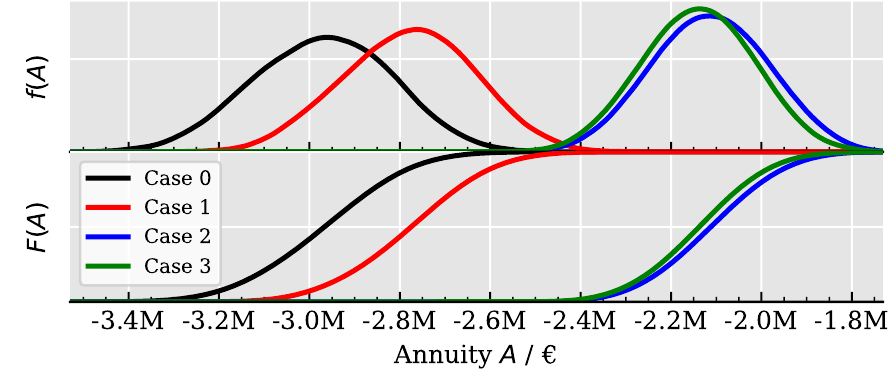
Figure 6. Presentation of exemplary Monte Carlo Simulation (MCS)-based risk analysis results generated by the described methodology. The statistical analysis of the economic KPI as an annuity according to VDI 2067 for four different design alternatives can be seen, which differ both in the average expected result and in their distribution around this